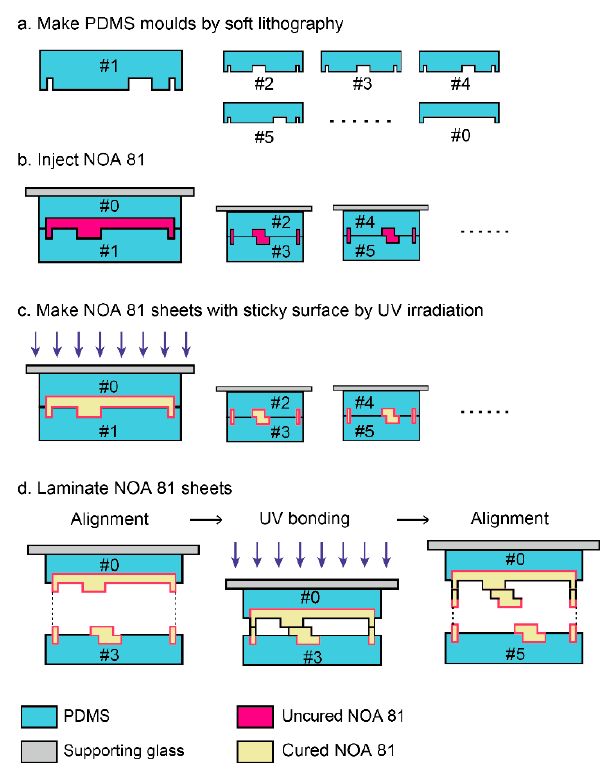
Figure 1. Schematic cross-sectional illustrations of the 3D fabrication process by conventional photolithography with NOA 81. ( a ) Fabricated PDMS molds by soft lithography. The numbers indicate layer order and #0 is a mold for a lid. ( b ) Injection of uncured NOA 81 to the spaces between PDMS molds by capillary force. ( c ) UV irradiation for partially curing NOA 81. ( d ) Lamination of NOA 81 sheets. NOA sheets are aligned after one side of PDMS molds are peeled off. The sheets are bonded by UV irradiation. The alignment and UV bonding processes are repeated.